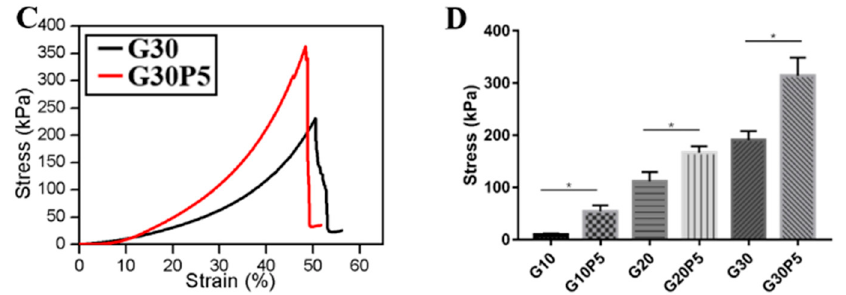
Figure 6. ( A – C ) Compression stress-strain curves of GelMA and GelMA/PEGDA hydrogel; ( D ) the maximum compressive stress of different hydrogels (* P < 0.05).